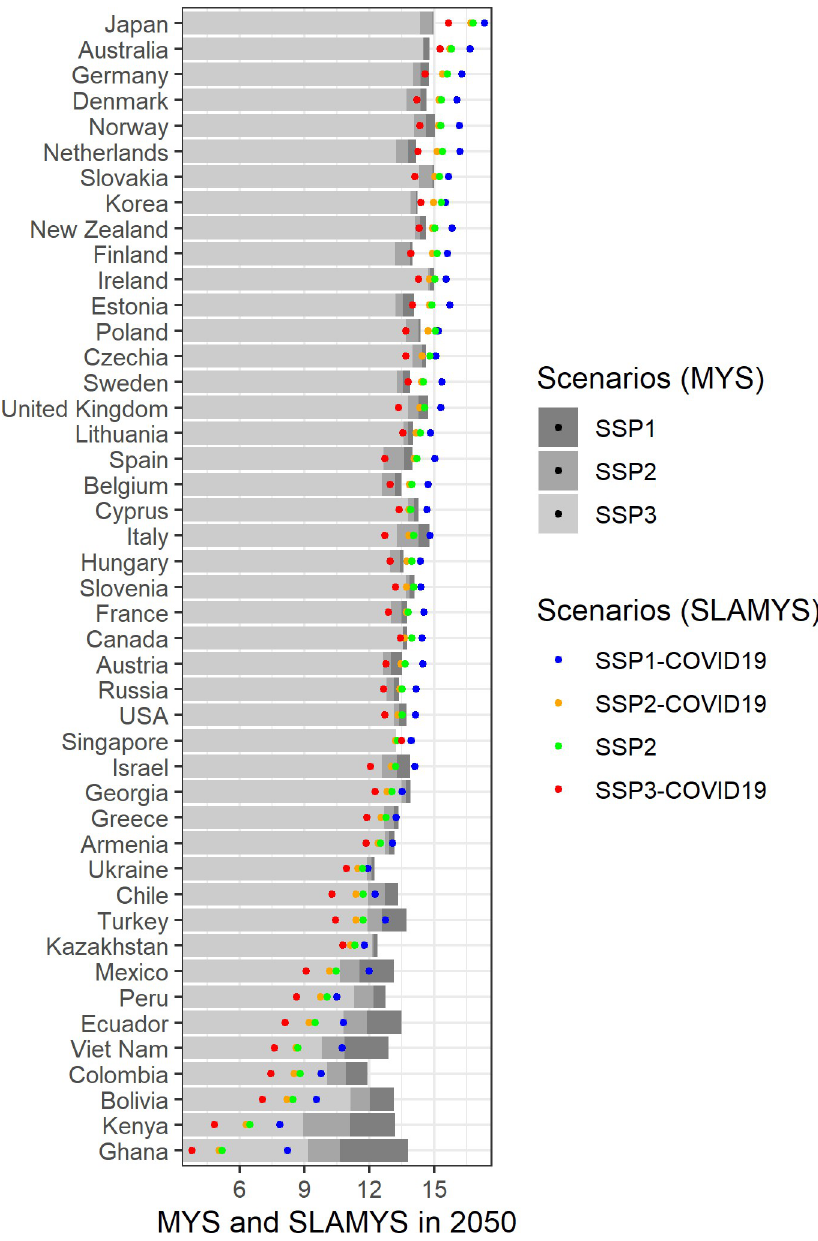
Fig 3. Projections of MYS and SLAMYS, several scenarios, 2050. Source: Authors’ own calculations. Note: Data sorted by projected SLAMYS according to SSP2-COVID19